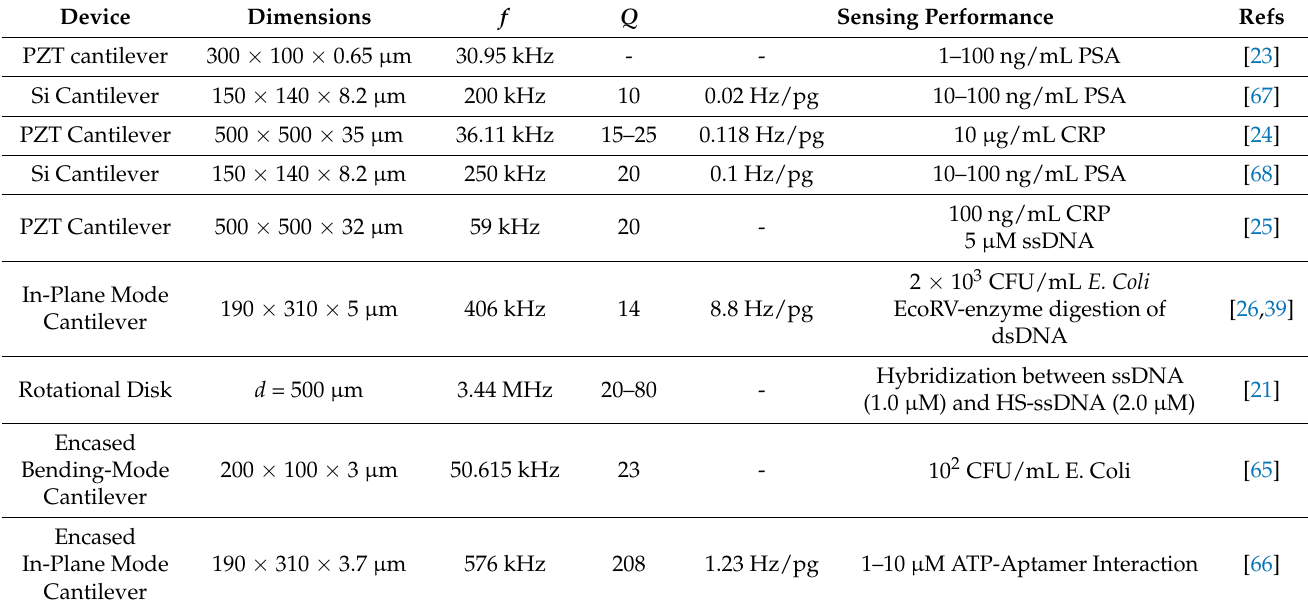
Figure 7. Detection of Hg 2+ in liquid droplets using a tri-beam extensional-mode resonator. ( a ) SEM images showing a microcantilever sensor with loaded mesoporous silica. ( b ) Frequency responses of the resonator to 500 ppb and 1 ppm Hg 2+ ion in solution. Reprinted with permission from [20]. Copyright 2016 IEEE. Table 3. Integrated Resonant Microgravimetric Sensors for Biological Detection in